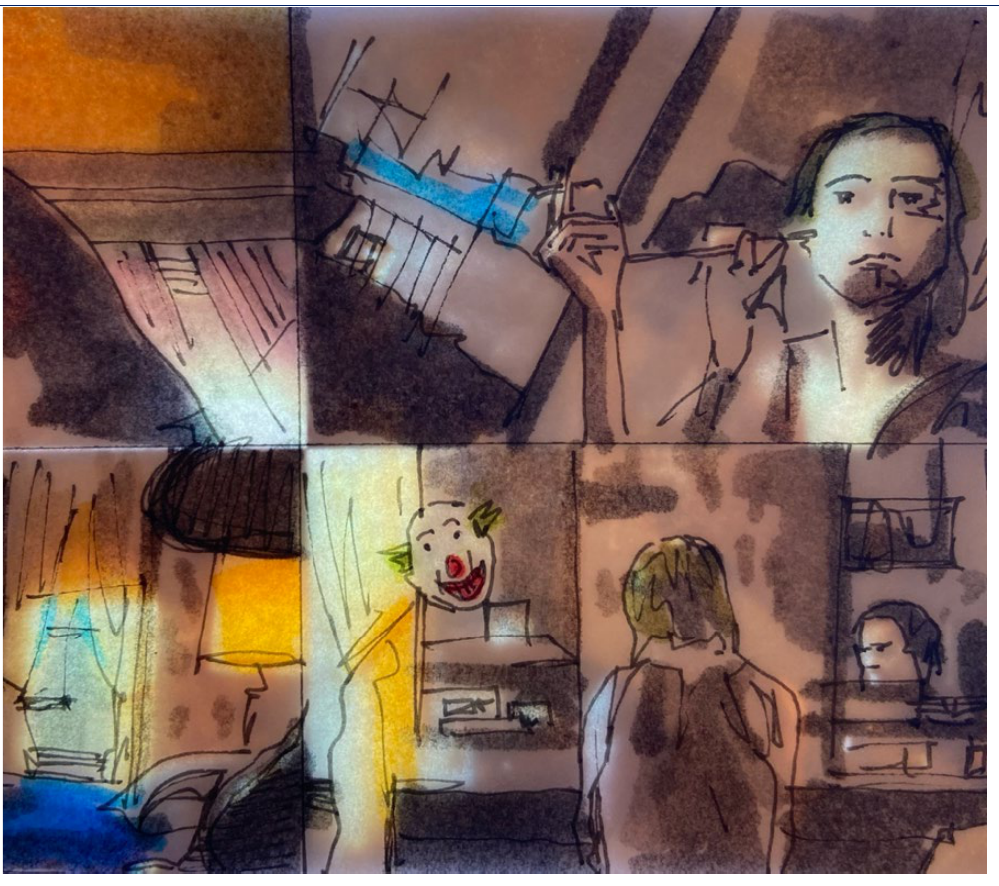
Figure 23 Detail of storyboard compiled of mask scene